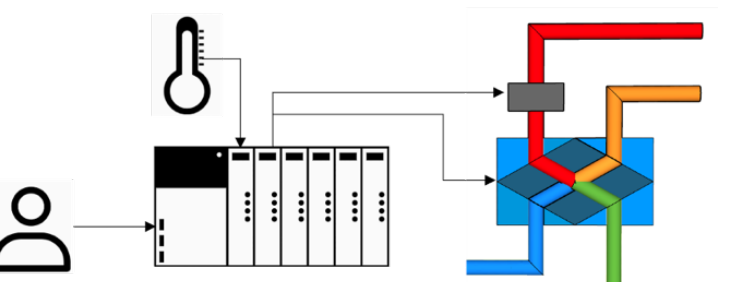
Figure 12. Control of the HVAC system concept.